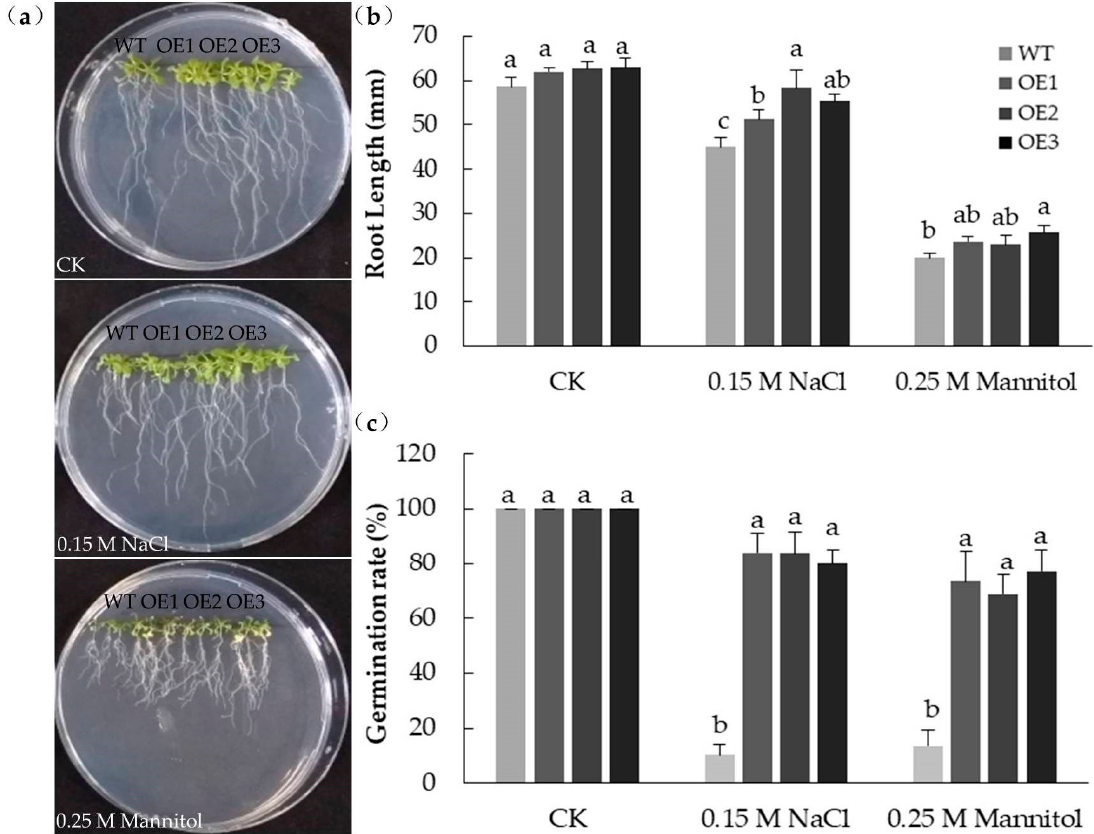
Figure 9. Heterologous expressing MpPIP2;1 enhanced seeds germination and root elongation in A. thaliana either under salinity or osmotic stress. ( a ) The phenotype and ( b ) the statistical analyses of the root lengths of transgenic lines and wild type seedlings growing on MS medium (CK), or MS medium with 0.15 M NaCl or 0.25 M mannitol for 14 days; ( c ) germination rate of transgenic and wild type seeds on different mediums for 7 days. The value presented was the mean ± SD of three replicates, and the bar with different letter was significantly different between plants at p < 0.05.